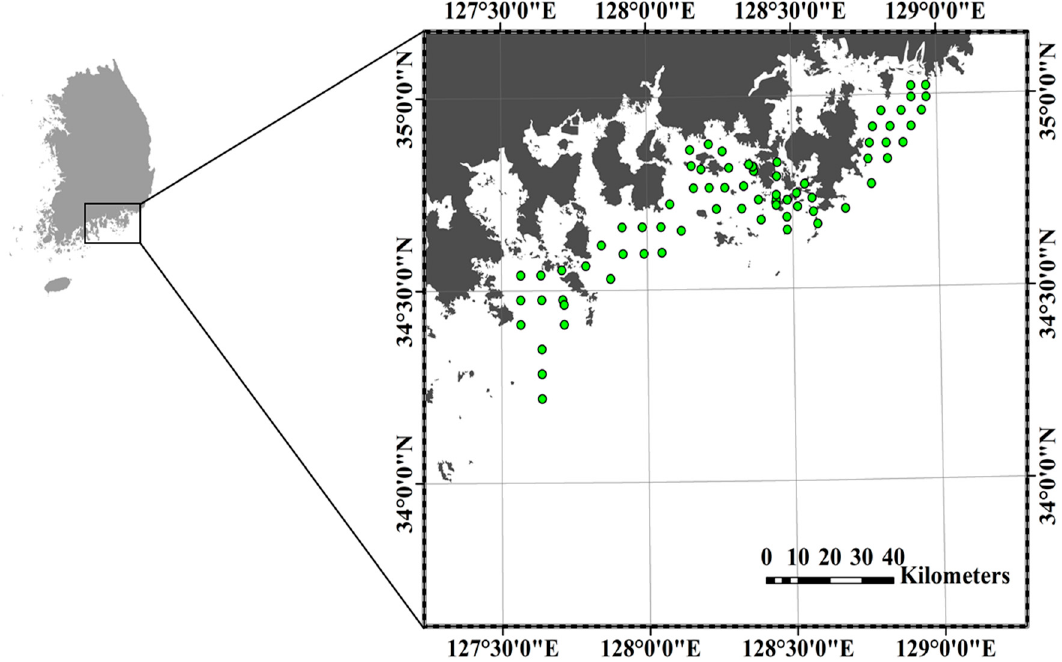
Figure 1. Map of research site including field sampling stations (green circles). Table 1. Landsat-8 Operational Land Imager (OLI) image information.